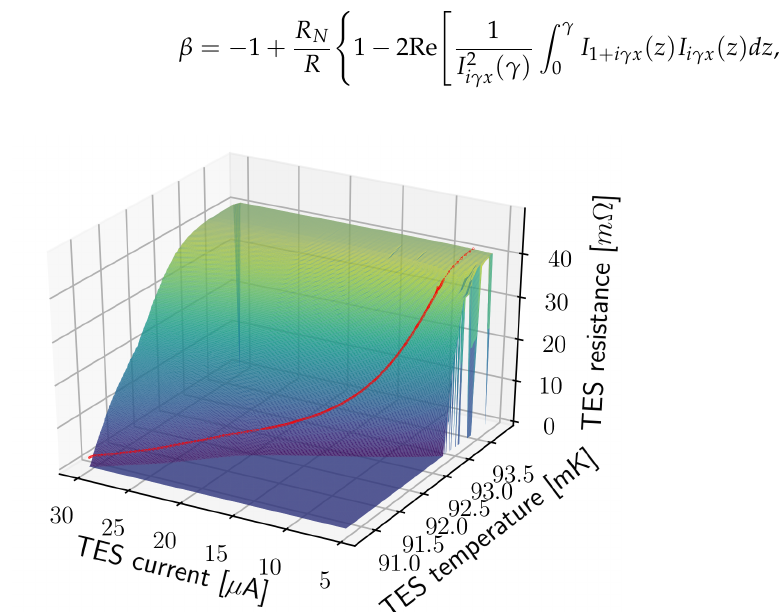
Figure 2. Example of an R(T,I) curve calculated for an X-ray TES calorimeter developed for X-IFU. The red curve shows the TES bias